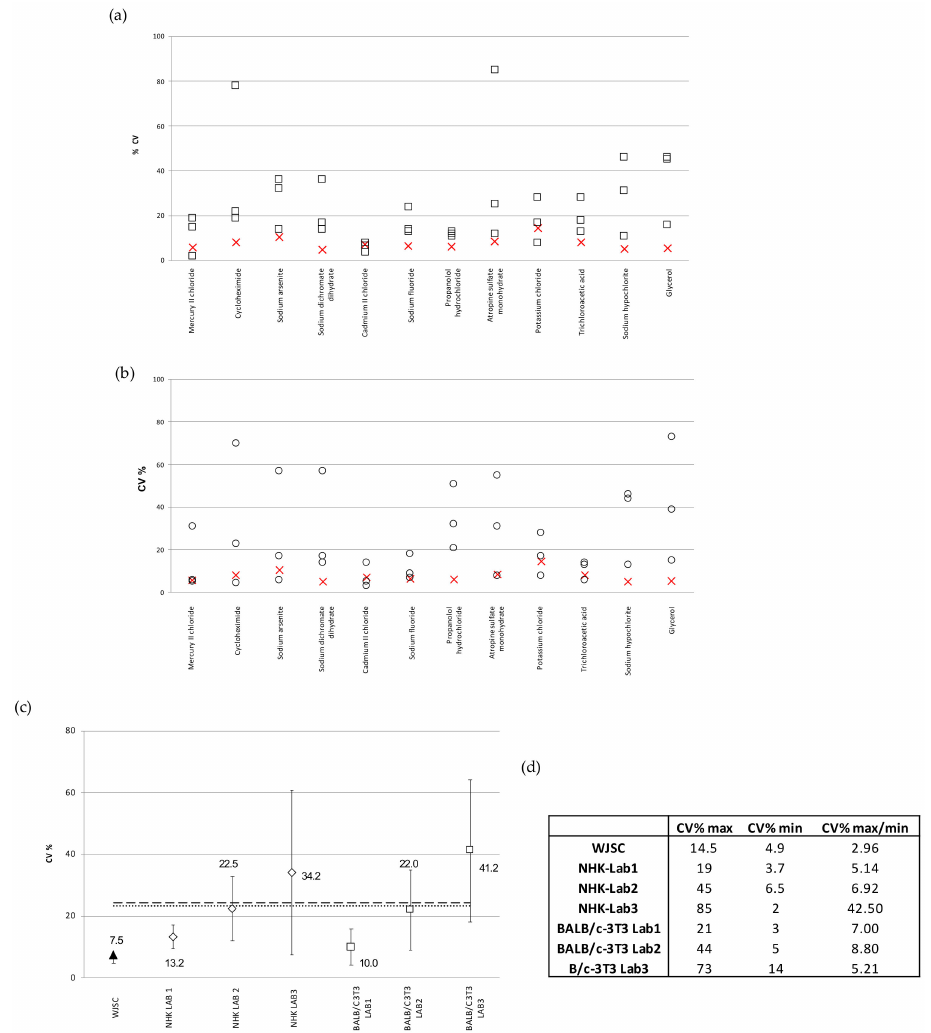
Figure 6. Reproducibility of the WJSC-based toxicity assay: ( a ) Comparison of inter-laboratory variation (CV%) of IC 50 values calculated by NHK-NRU toxicity assay in three different laboratories selected by the ICCVAM [6] (values displayed as squares), with those calculated based on the WJSC- NRU assay in our laboratory (values shown as “X”). The three plus one values in each column are the CV% values as recorded in the three ICVAAM laboratories and in our laboratory, respectively, for each of the 12 different substances, presented in descending order of toxicity from left to right along the x axis; ( b ) Comparison of inter-laboratory variation (CV%) of IC 50 values calculated based on the BALB/c 3T3-NRU toxicity assay (in three different laboratories selected by ICCVAM; values are shown as squares) with those calculated based on the WJSC-NRU assay in our laboratory (values shown as “X”). The three plus one values in each column are the CV% values as recorded in the three ICVAAM laboratories and in our laboratory, respectively, for each of the 12 different substances, presented in descending order of toxicity from left to right along the x axis. ( c ) Comparison of the mean inter-laboratory variation (CV% ± standard deviation) of IC 50 values derived from the three experimental triplicates with the lowest deviation for the total of 12 substances; horizontal lines = mean CV% of three labs (dashed = 3T3, dotted = NHK. ( d ) Mean inter-laboratory variation values (CV%) for the total of 12 substances